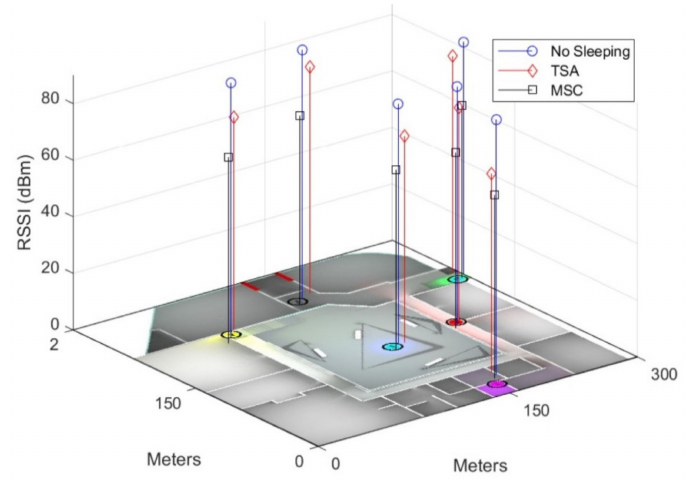
Figure 10. Analysis of the WiFi sensors under no sleeping, TSA, and MSC for LEACH (energy-aware